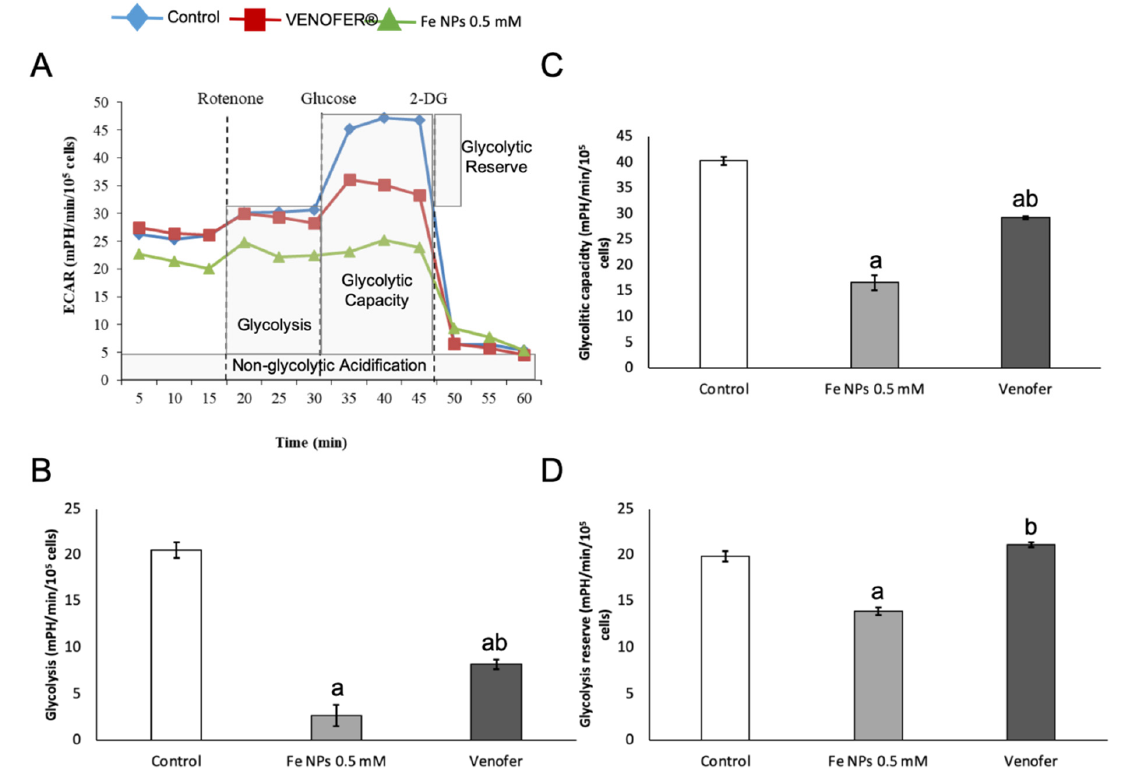
Figure 5. Effects on Mitochondrial glycolysis by iron nanoparticles in HT-29 cells. Cells were treated with DMEM (ctrl), iron nanoparticles Fe NPs or Venofer ® for 24 h. ECAR was determined by using the Seahorse XF-24 Extracellular Flux Analyzer after the injections of rotenone (1 µmol L − 1 ), glucose (30 mmol L − 1 ) and 2-DG (100 mmol L − 1 ). Glycolytic capacity was calculated from the XF glycolysis stress test profile. ( A ) shows ECAR. ( B ) shows glycolysis. ( C ) shows the glycolitic capacity. ( D ) shows the glycolysis reserve. Data are indicated as the mean ± SEM ( n = 3). (a) vs. control; (b) vs. Fe NPs 0.5 mmol L − 1 ( p < 0.05).